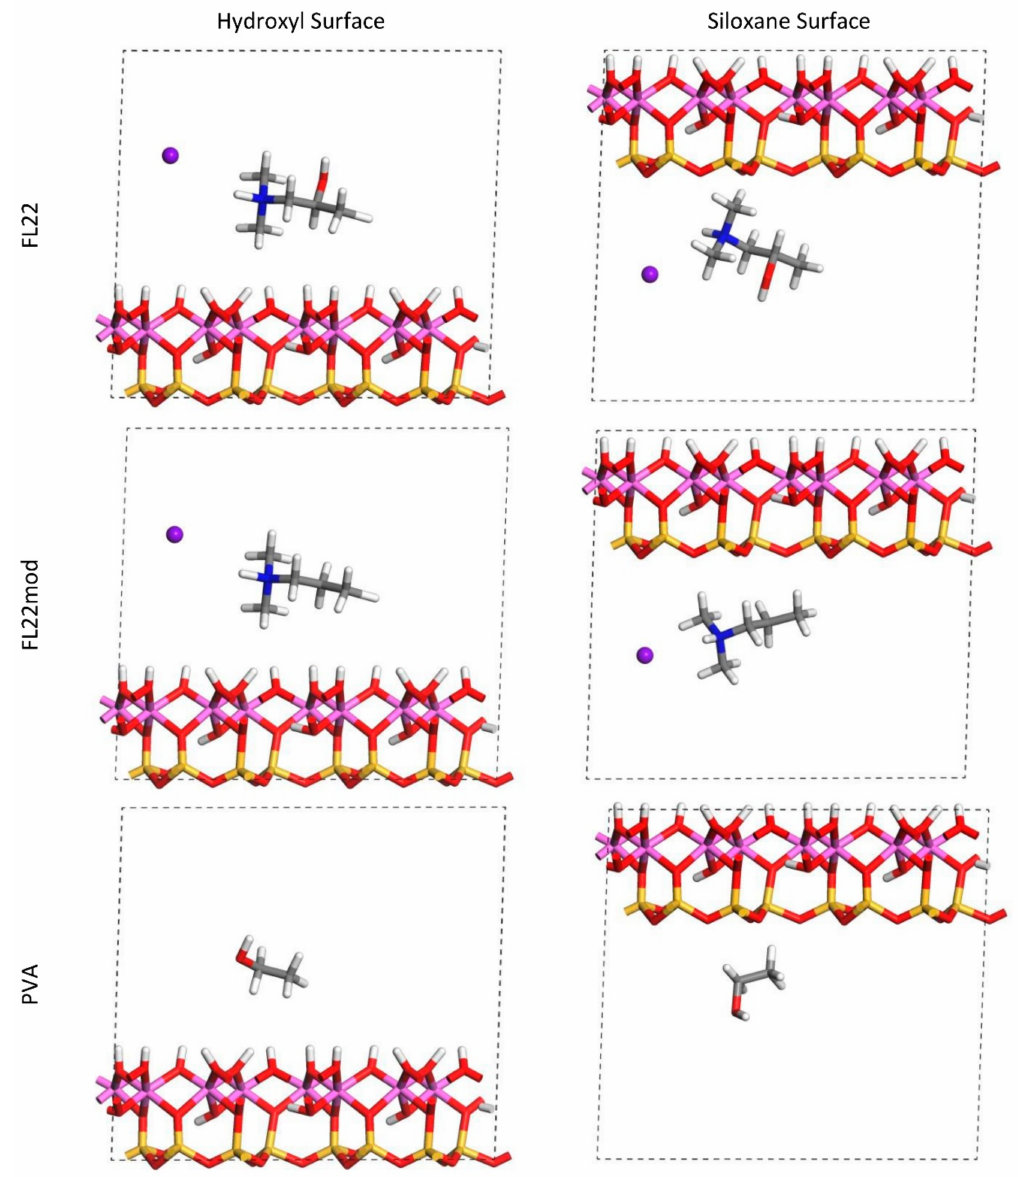
Figure 1. Orientation 1—Initial configurations of the monomer/surface models where the OH-group of the monomer points away from the surface. Colour scheme (used for all figures): white—hydrogen; red—oxygen; pink—aluminium; yellow—silicon; grey—carbon; blue—nitrogen;